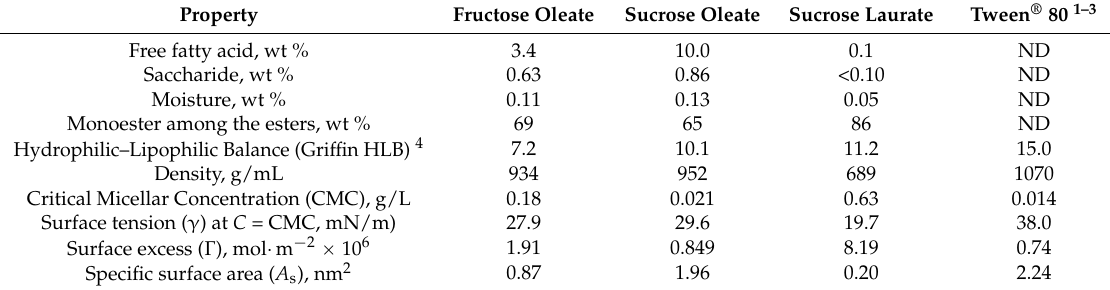
Table 1. Comparison of chemical and surfactant-related properties of sucrose oleate and fructose oleate, prepared from the enzymatic reaction, versus sucrose laurate and Tween ® 80 1 , commercial emulsifiers, at 22 ˝